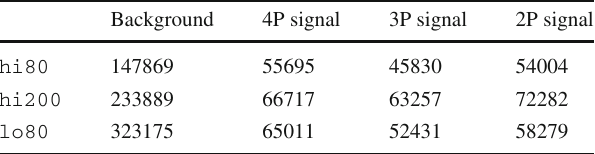
Table 1 Number of events used in the optimisation and test of the taggers with the LoRD method